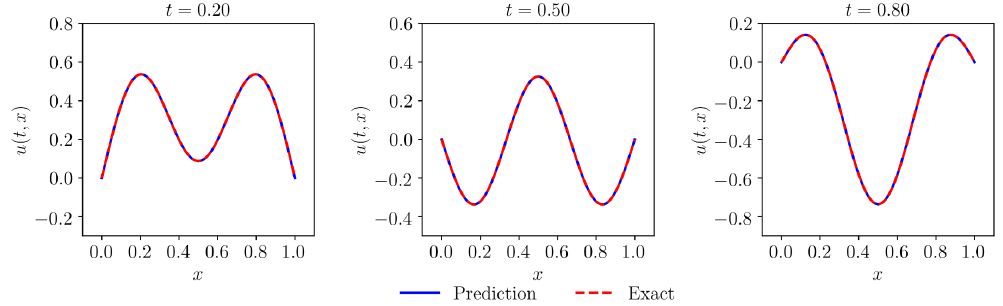
Figure 4. Comparison of the prediction given by physics-informed neural networks with the exact